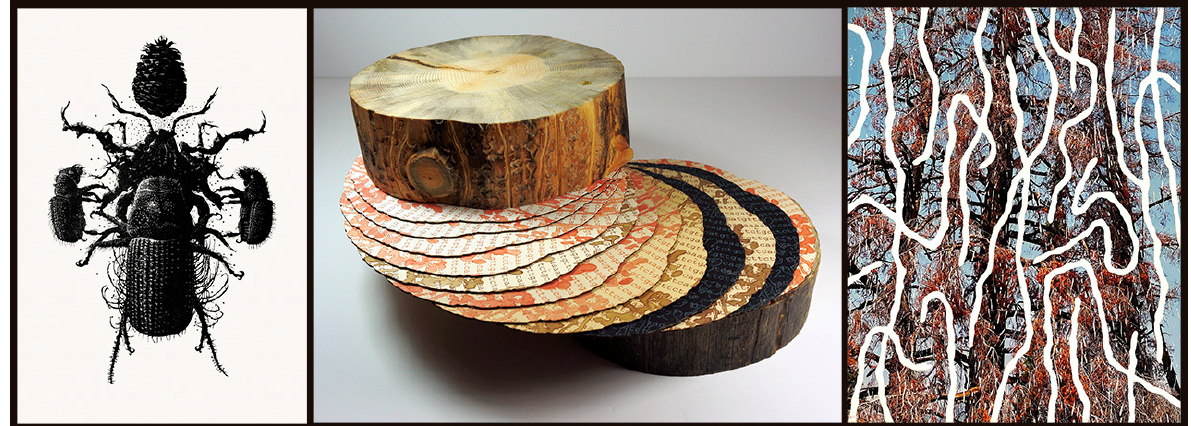
Figure 8. Bark beetles as vehicles for addressing environmental destruction. Certain species or